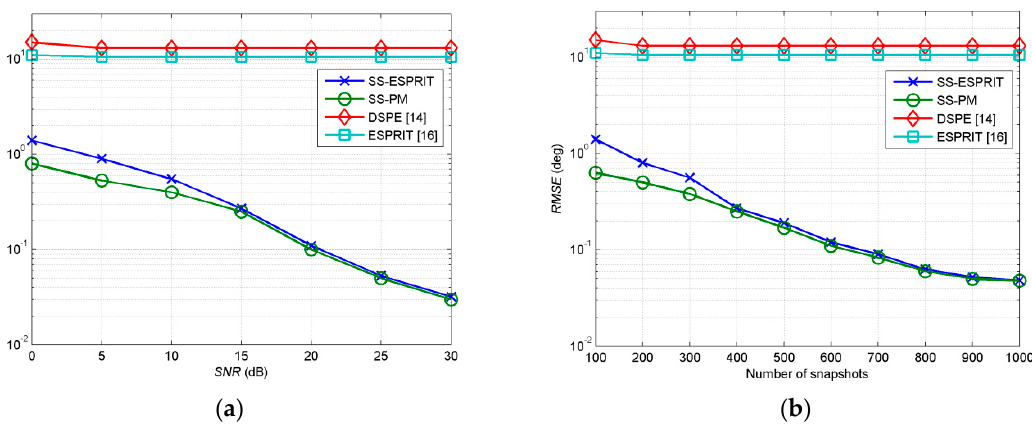
Figure 3. ( a ) RMSE estimated by propose methods for 2D coherent CD sources versus SNR ; ( b ) RMSE estimated by three methods for 2D coherent CD sources versus number of snapshots.